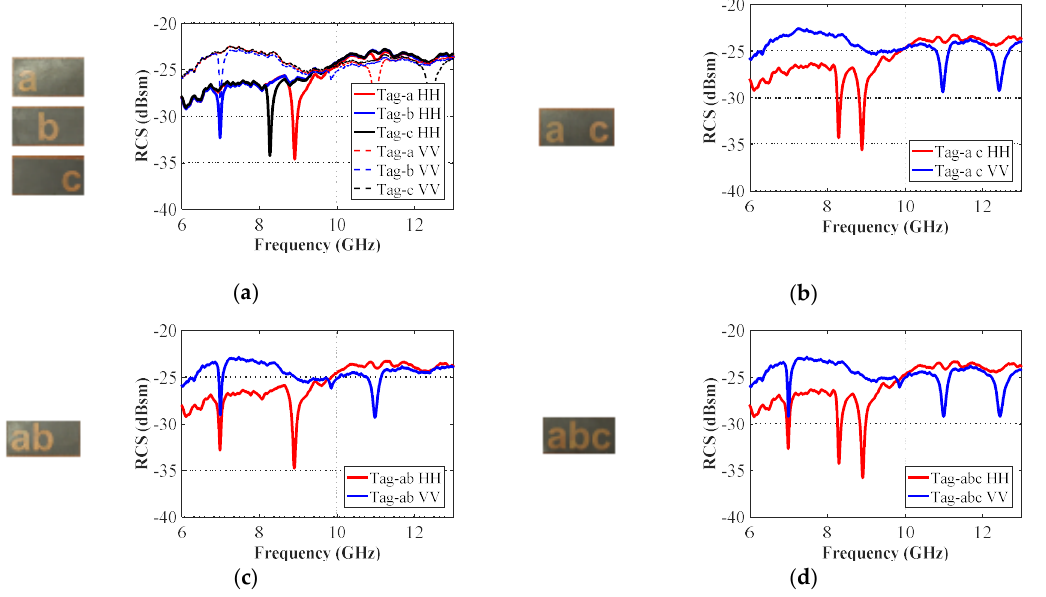
Figure 24. Measurement co-polar (HH/VV) RCS results: ( a ) Tag-a, -b, and -c; ( b ) Tag-a c; ( c ) Tag-ab; ( d ) Tag-abc.